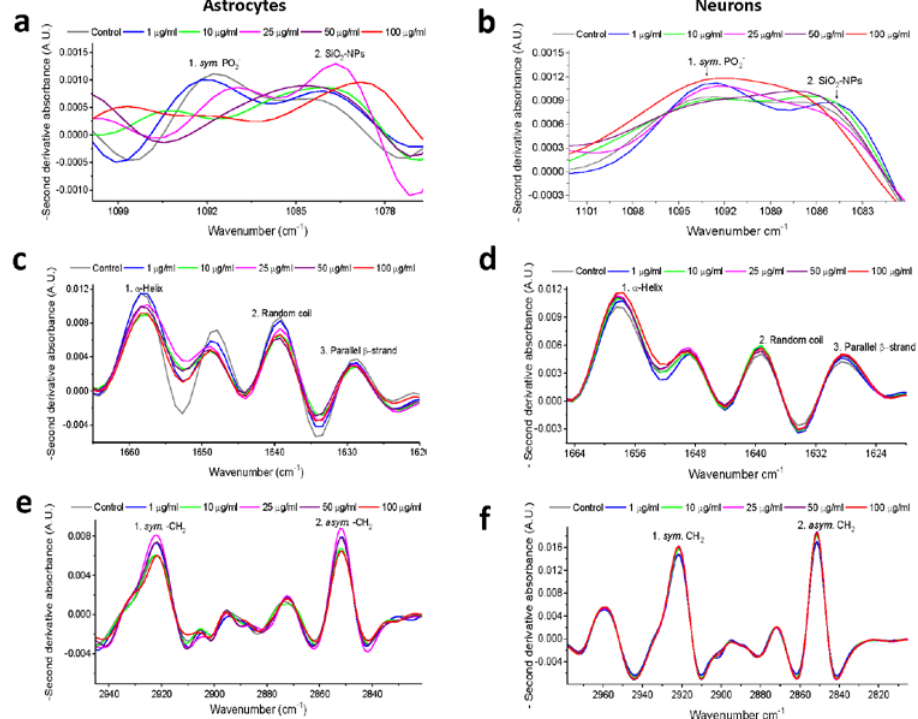
Figure 4. Second derivative spectra analysis of nucleic acids, amide I and lipid regions after SiO 2 -NPs exposure. Nucleic acids correspond to symmetric PO 2 − at 1090 cm − 1 , and SiO 2 -NPs correspond to 1083 cm − 1 spectral band in ( a ) astrocytes and ( b ) neurons. The secondary structure of proteins corresponds to the amide I region, which includes the 1627 cm − 1 for parallel β -strand, 1639 cm − 1 for random coil, and 1654 cm − 1 for alpha-helix in ( c ) astrocytes and ( d ) neurons. Lipids correspond to 1852 cm − 1 for symmetric -CH 2 and 2923 cm − 1 for asymmetric -CH 2 in ( e ) astrocytes and ( f ) neurons.